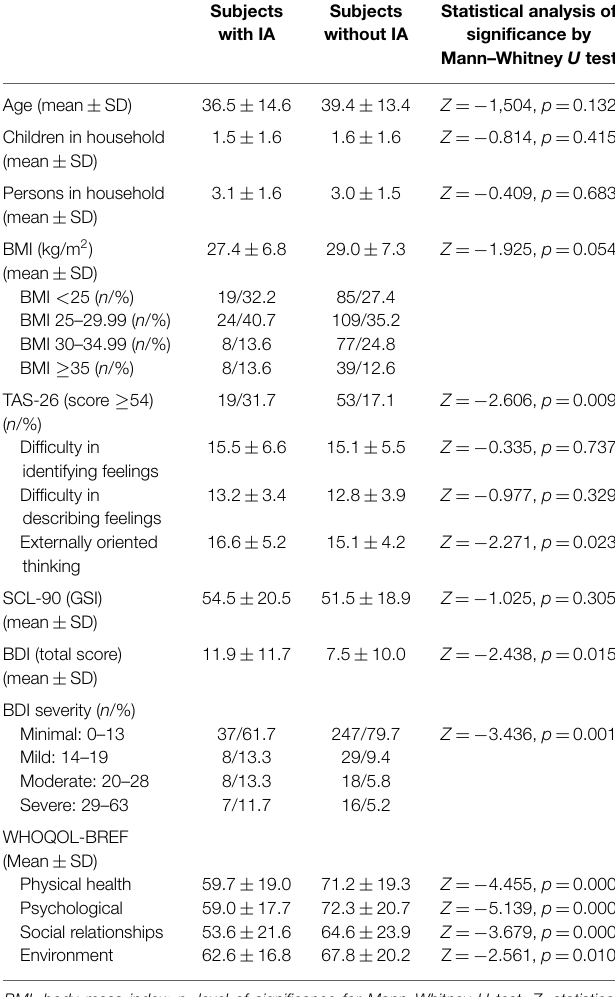
TABLE 3 | Comparison of subjects with and without IA .